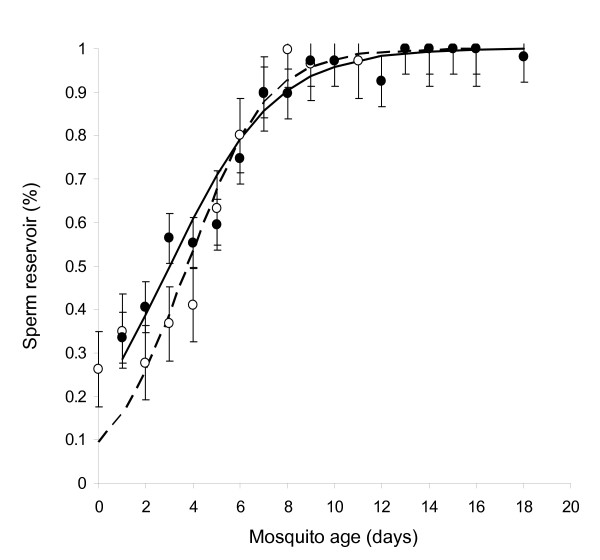
The proportion of the testis occupied by the sperm reservoir as male An. gambiae age. The sperm reservoir expanded faster in virgins (grey broken line and open circles) than in males who had mated once (solid black line and dark circles).